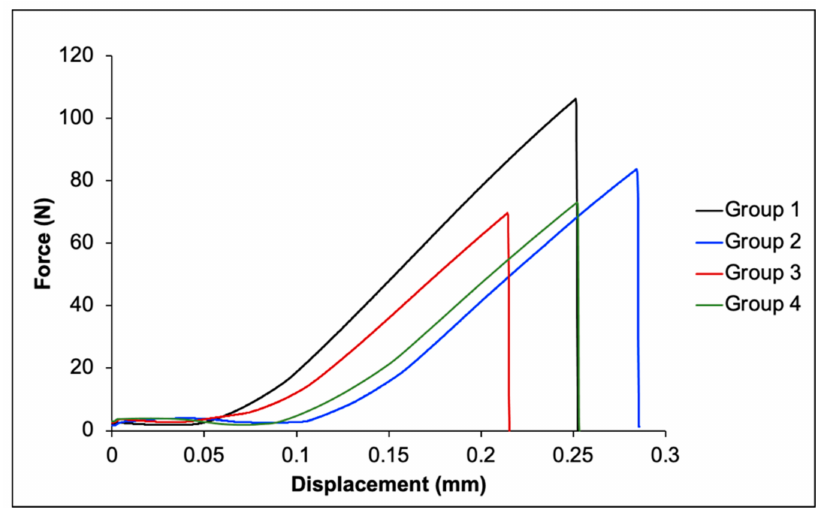
Figure 6. Representative force–displacement diagram from BFS